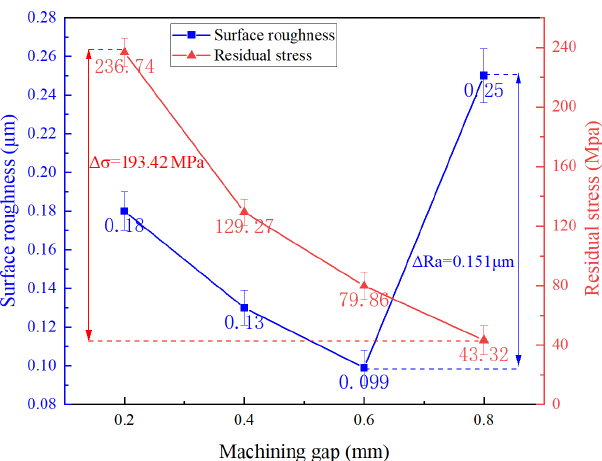
Figure 11. Effect of different working clearance on surface rough- ness of the